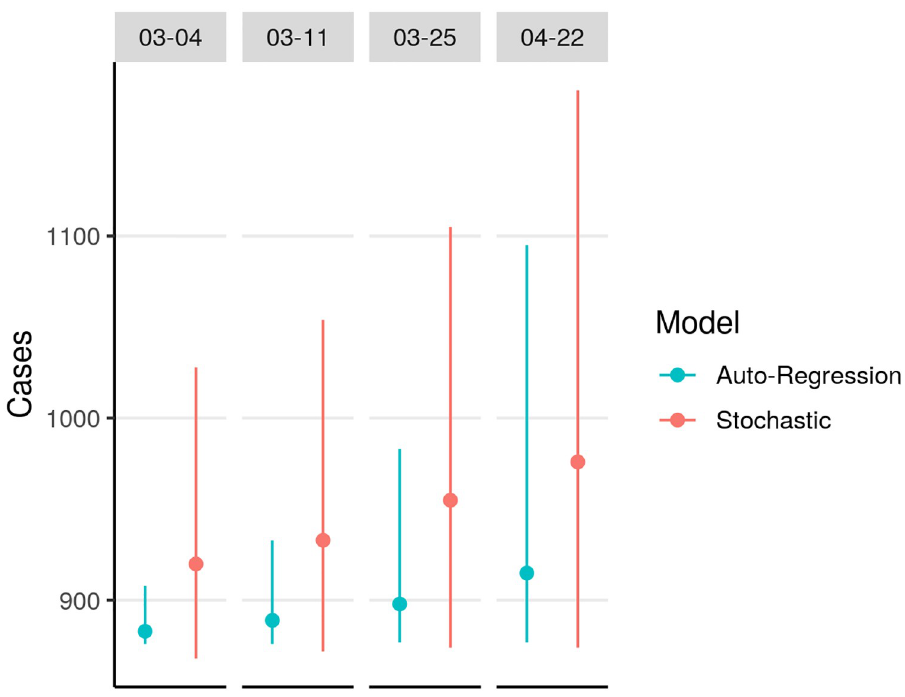
Fig 5. Medians and prediction intervals from short-term projections of case counts based on reported counts as of February 25, 2019. Solid dots indicate median count.